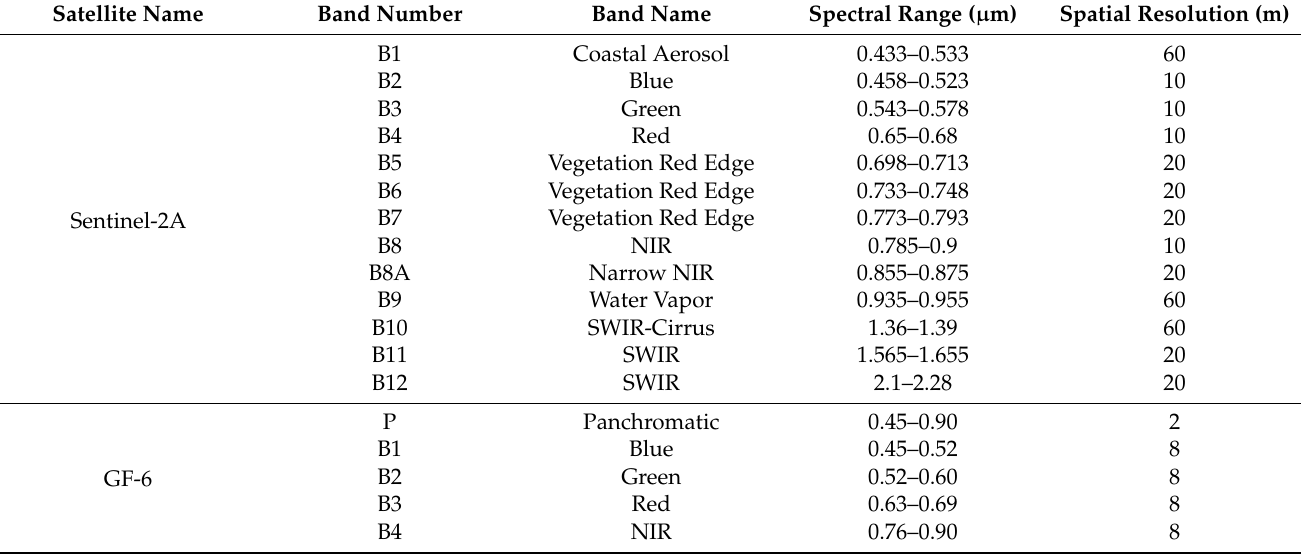
Table 2. Parameter information for the Sentinel-2A and GF-6 satellite